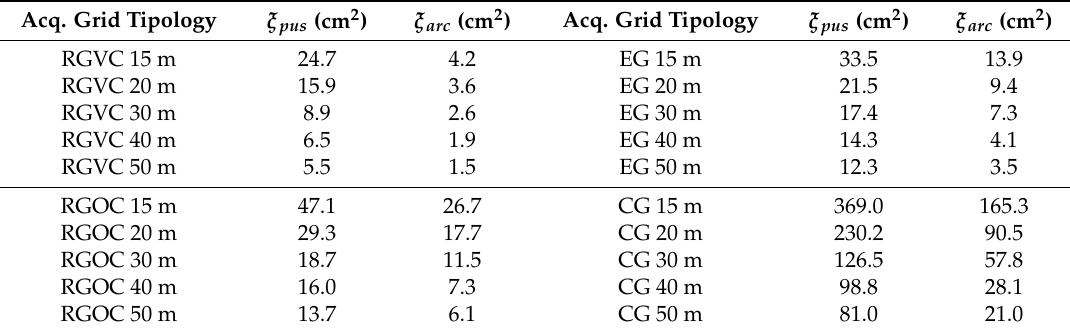
Table 6. ξ factors for the 20 surface